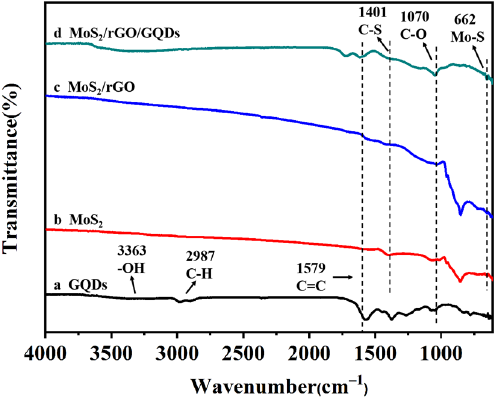
Figure 7. FT-IR spectra of GQDs MoS 2 , MoS 2 /GQDs and MoS 2 /rGO/GQDs.